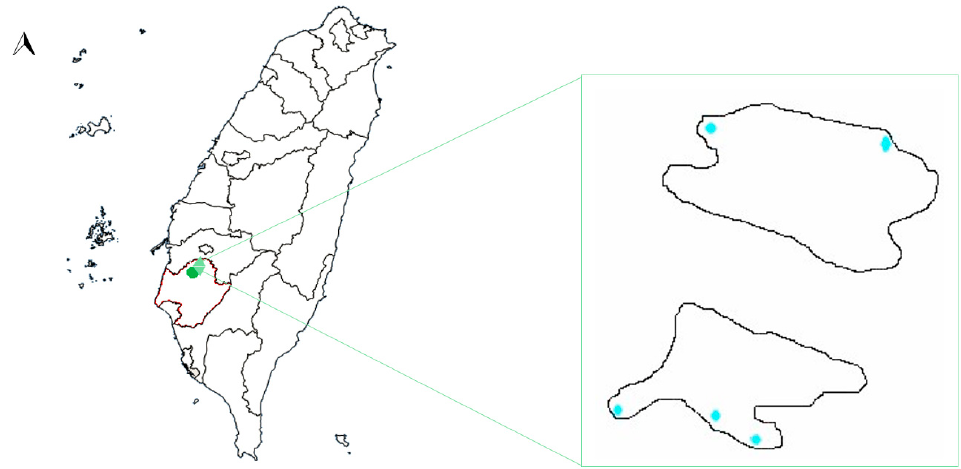
Figure 1. Map of Taiwan with the location of Hulupi Lake (23°12 ′ 33.6 ′′ N 120°19 ′ 49.1 ′′ E) and the lake map. The two parts of the lake are separated by an asphalted road. The points are the sampling locations for the study.